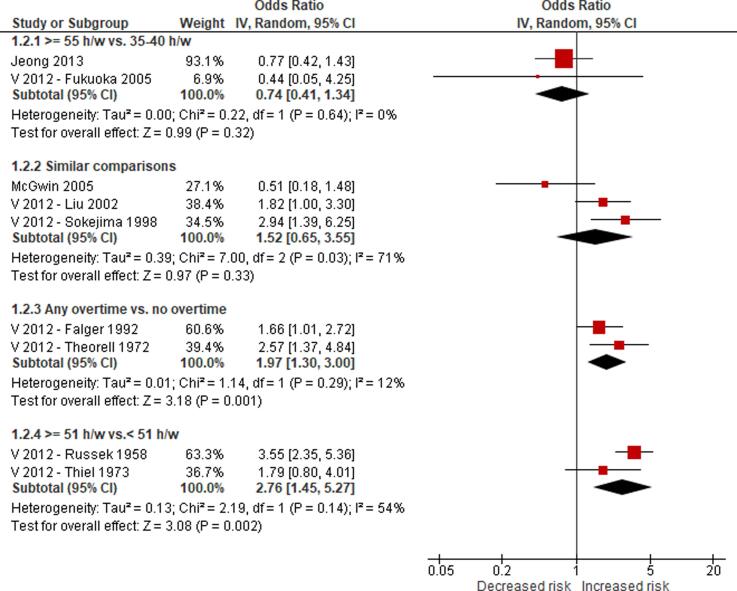
Supporting meta-analysis of deprioritized evidence (case-control studies), Outcome: Acquired ischaemic heart disease, Comparison: Worked ≥55 h/week compared with worked 35–40 h/week (or similar comparisons, or any overtime work). Footnotes: The similar comparisons included in this meta-analysis were: McGwin 2005: >50 h/w vs. <40 h/w; Virtanen 2012 - Liu and Tanaka, 2002: ≥61 h/w vs. ≤40 h/w; and Virtanen 2012 - Sokejima and Kagamimori (1998): ≥11.01 h/d vs. 7.01 to 9.00 h/d.